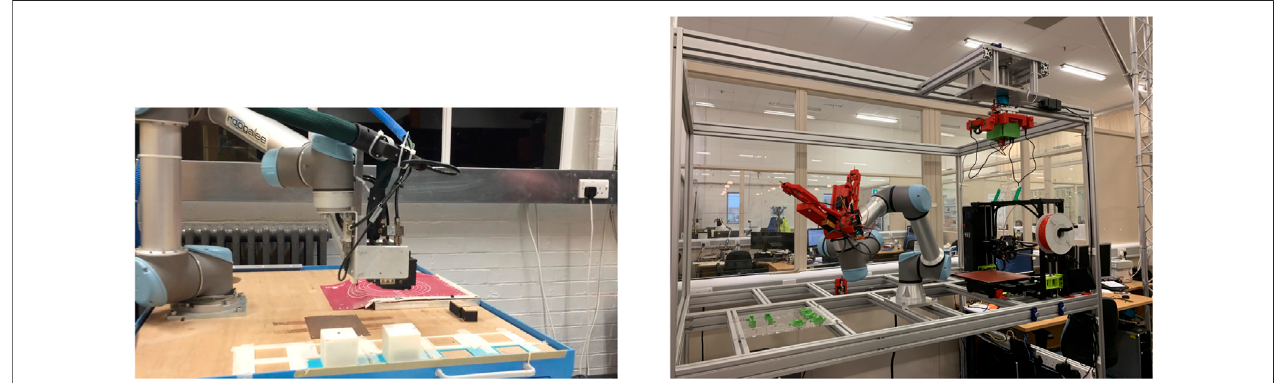
FIGURE 3 | Two examples of a working Robot Fabricator. (A) The system in Cambridge, cf. Brodbeck et al. (2015). (B) The system in Bristol, cf. Hale et al.